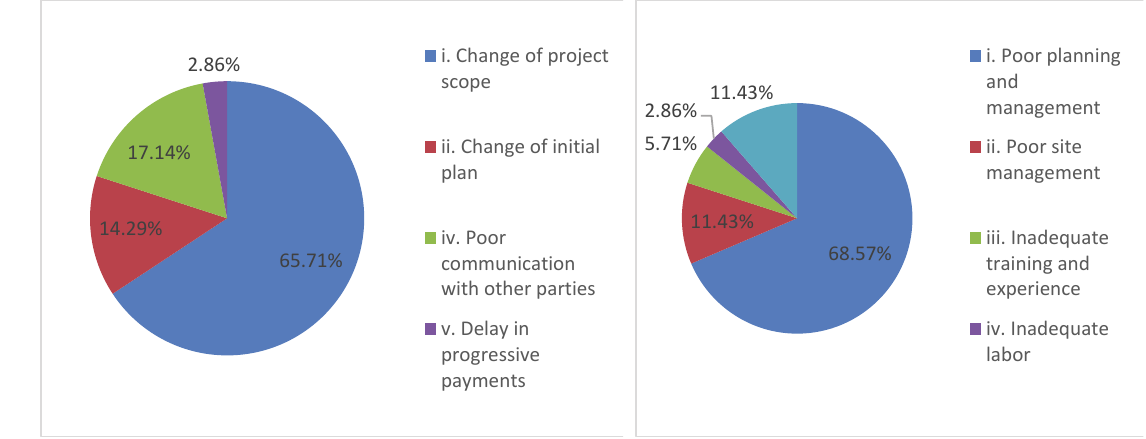
Fig. 5. Client-related causes Fig. 6. Contractor related